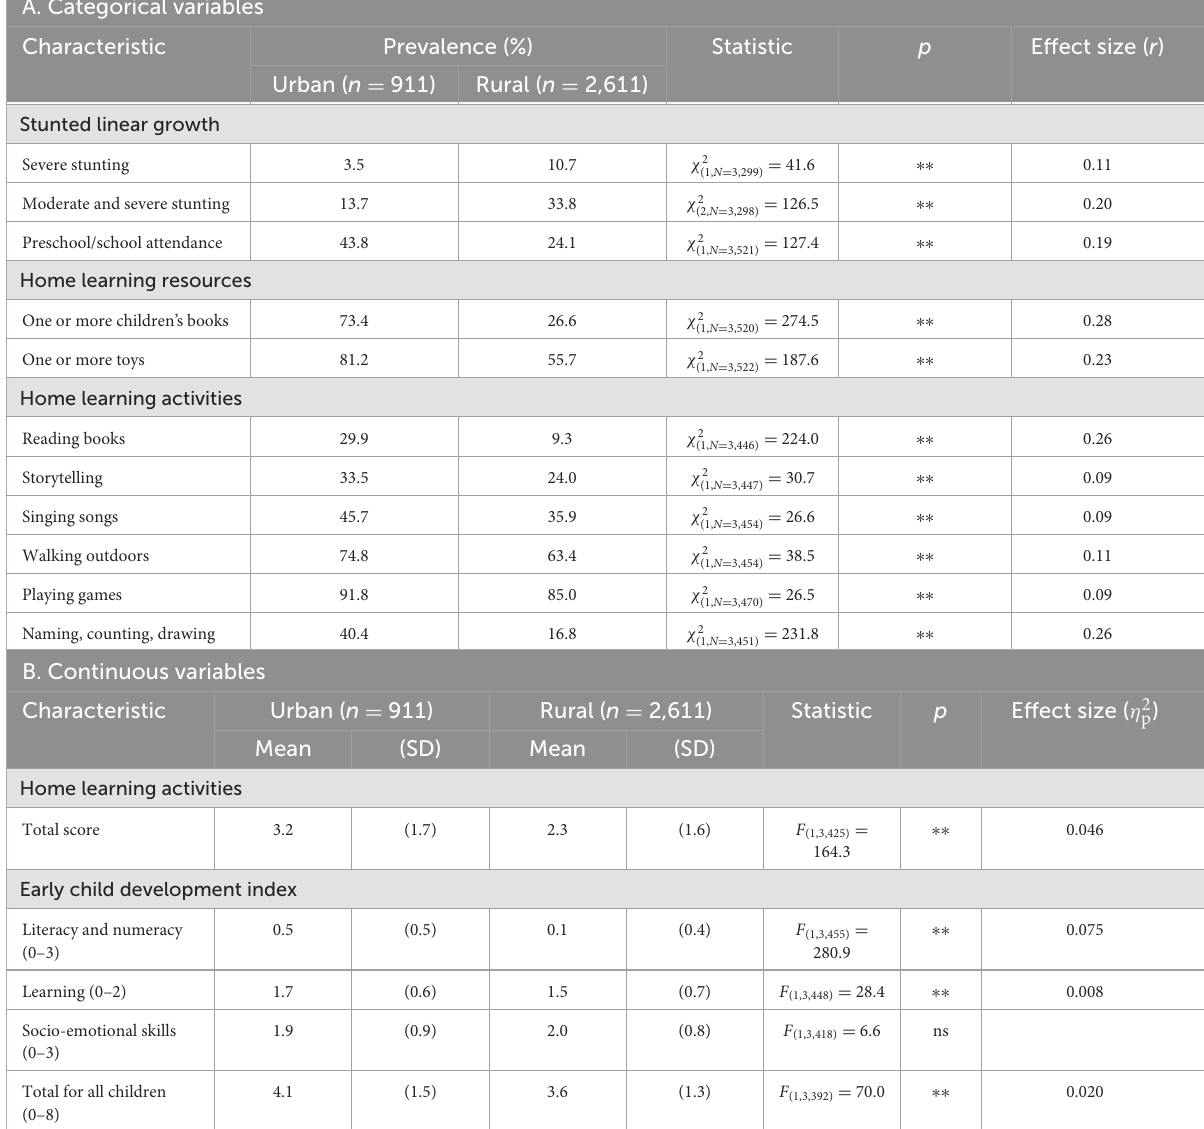
TABLE 2 Urban–rural differences in the main variables among 36- to 59-month-old children in Côte